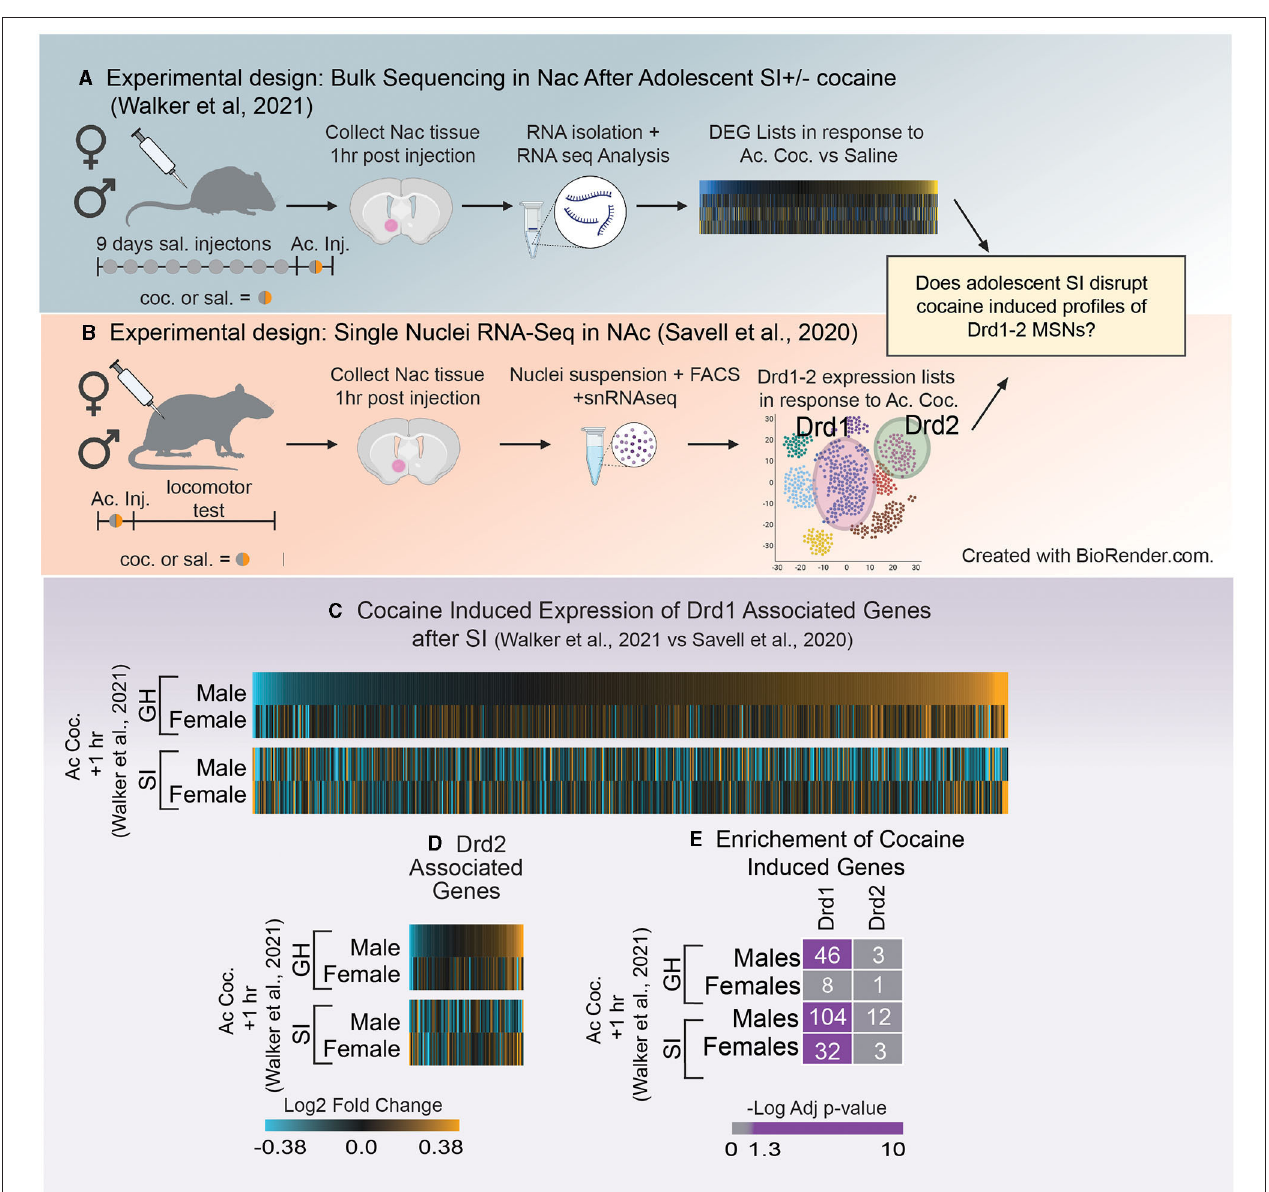
FIGURE 4 | (A) Schematic of experimental design utilized in Walker et al. (121) which investigated how adolescent social isolation disrupts the transcriptomic effects of cocaine in males and females. (B) Schematic of experimental design utilized in Schematic of Savell et al. (125) which used single nuclei RNA-seq to determine transcriptional profiles nuclei RNA-seq to determine transcriptional profiles of Drd1 and Drd2 MSNs. (C,D) Heatmaps of expression of Drd1 associated genes (C) and Drd2 associated genes (D) after the first dose of cocaine in group housed (GH) and socially isolation (SI) males and females. Unlike GH males SI males downregulate expression of Drd1 and 2 associated genes after a first dose of cocaine. (E) Enrichment of Drd1 and Drd2 associated genes and those altered by a single dose of cocaine in GH and SI males and females. GH males but not females regulate Drd1 associated genes in response to the first dose of cocaine. In SI animals, both males and females regulated Drd1 associated genes. Purple = significant enrichment, gray = non-significant enrichment; numbers in boxes = number of genes overlapping between the two lists. cocaine ( ∼ 60% upregulated vs. ∼ 40% down) and this pattern was flipped after aSI in males but not females. These data